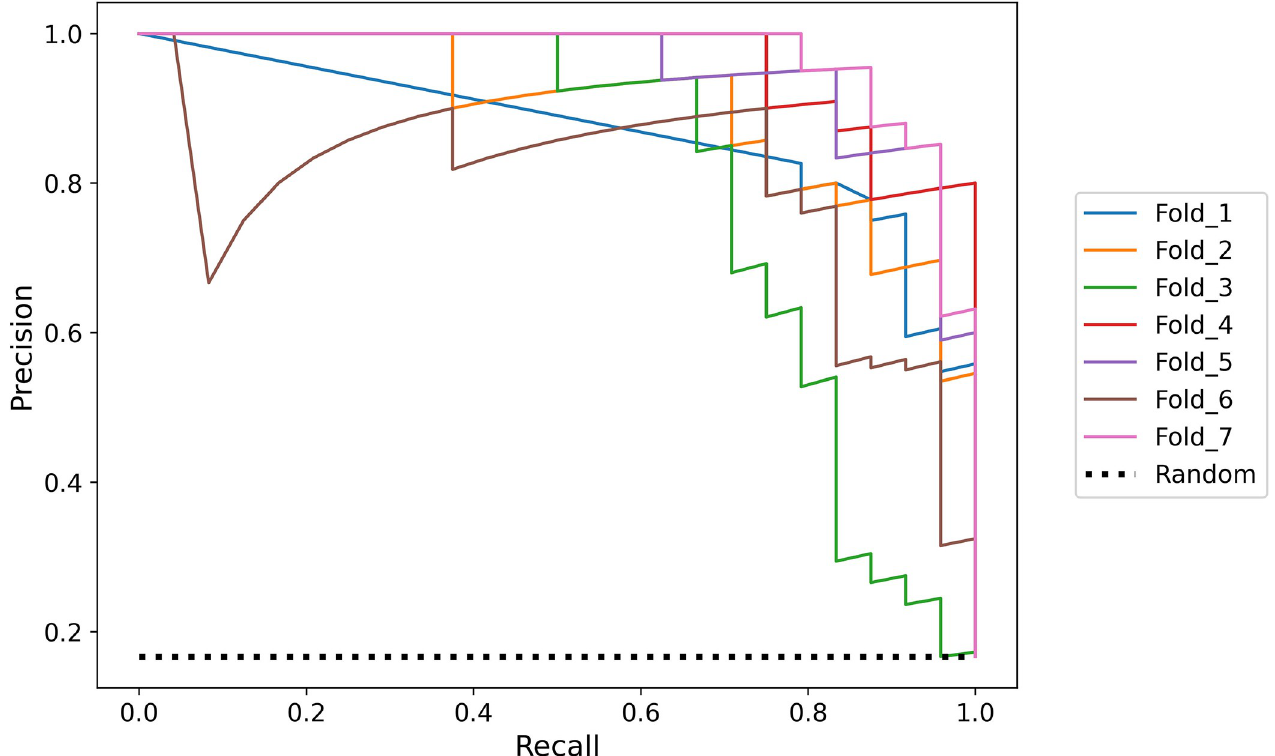
Fig 2. Recall-Precision (RP) curves of all the cross-validation folds (each fold is shown here in a different curve); the random classifier is depicted with a dashed line.